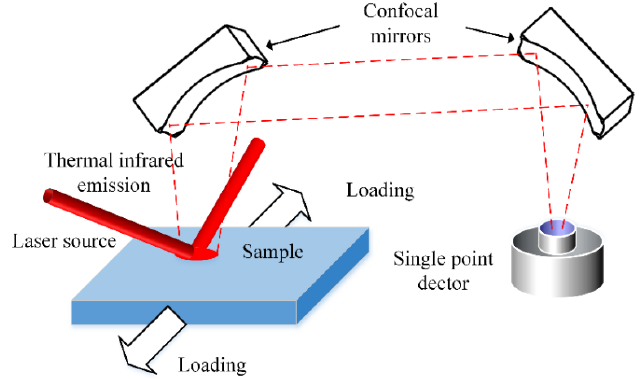
Figure 8. Schematic of lock-in photo-thermo-mechanical radiometry (PTMR) testing with a single-point detector and a confocal radiation collection system, redrawn based on [100].